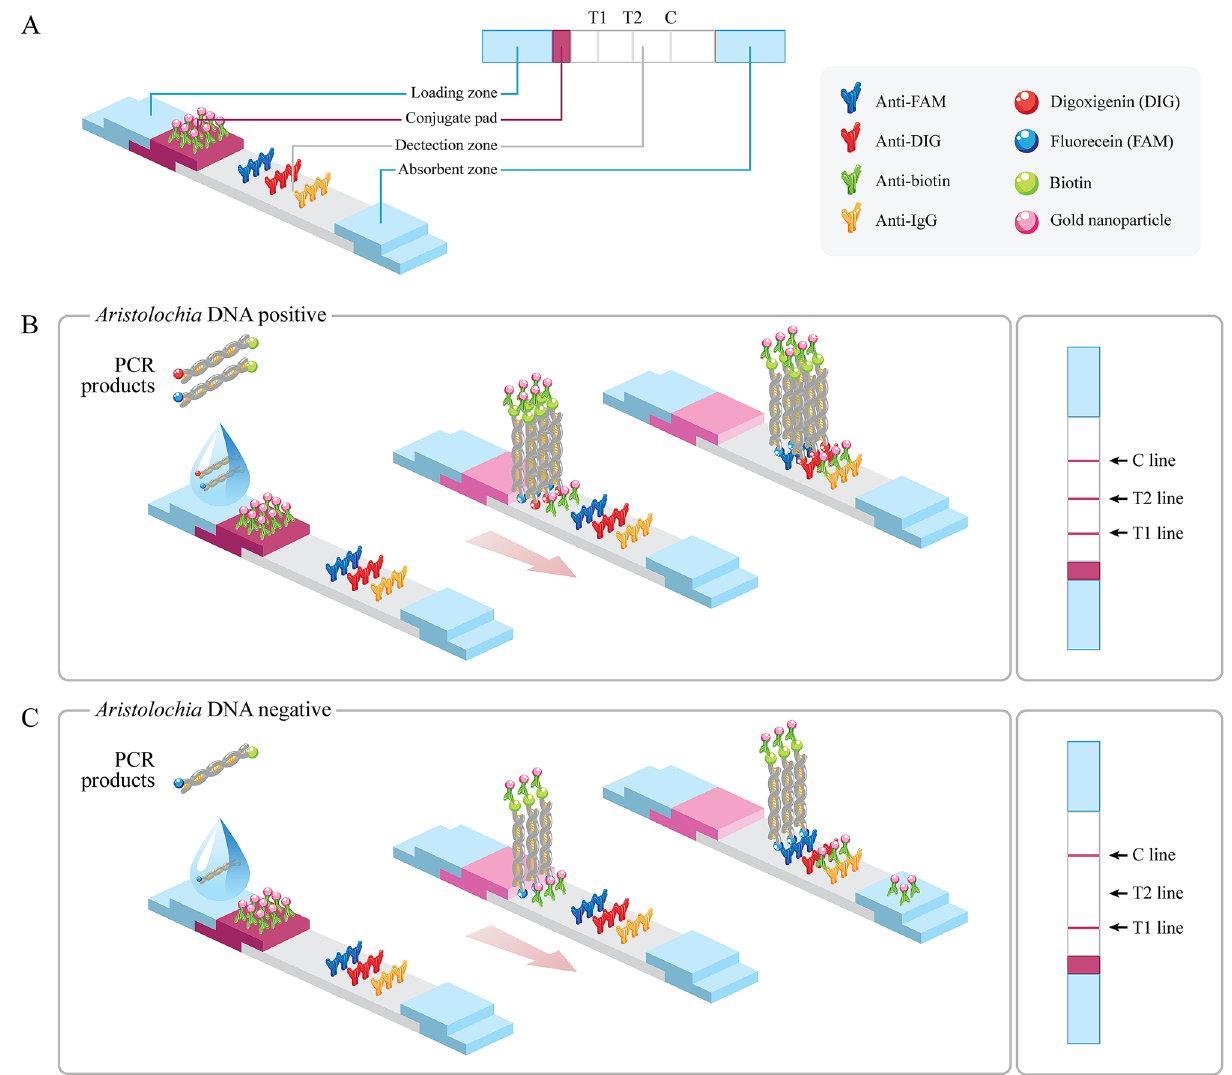
Figure 4. Principle of PCR-LFA to detect Aristolochia spp. ( A ) The following four elements of the LFA strip were used: loading zone, conjugate pad, detection zone and adsorbent pad with immobilized antibodies (anti- FAM, anti-DIG and anti-IgG) and adsorbent pad. ( B ) Aristolochia- LFA positive result, dual labeling of the internal control amplicon and the Aristolochia -specific amplicons bound to the antibiotin-gold nanoparticle conjugates at the conjugate pad and migrated through the detection zone. The complexes containing FAM and DIG were trapped by their specific antibodies at the detection zone, creating coloration at both the T1 and T2 lines. Unbound was captured by anti-IgG at the C line, ( C ) Aristolochia- LFA negative result, the dual labeling of internal control amplicon was migrated along the detection zone and pink color were observed at T1 and C lines but not T2